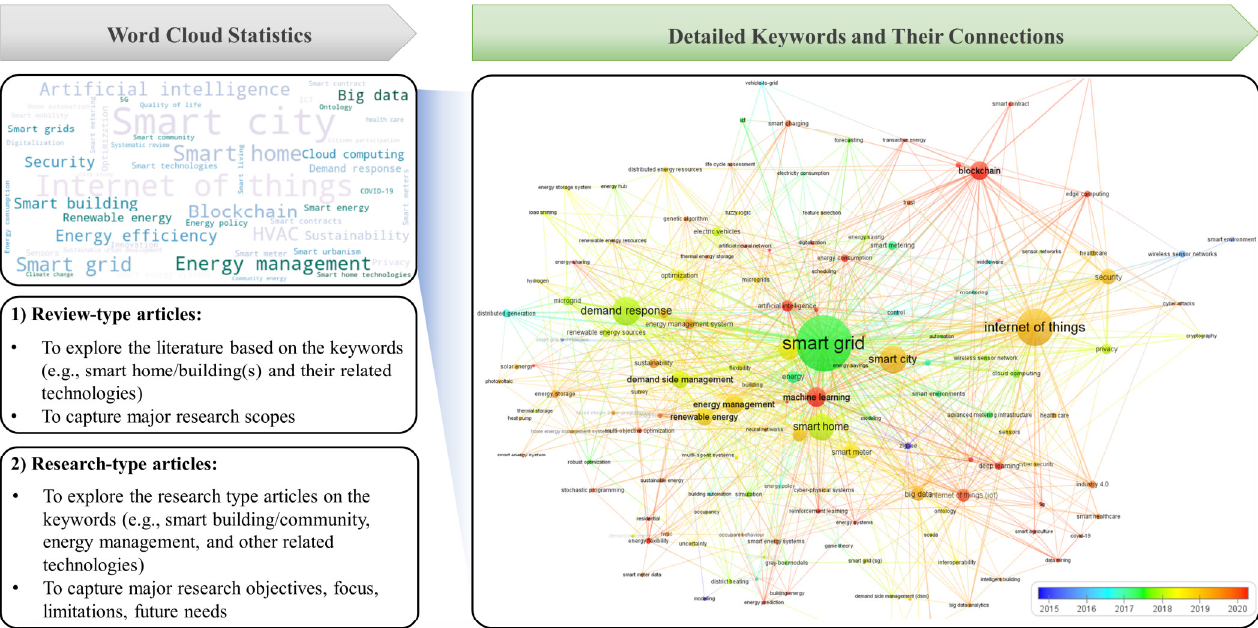
Figure 1. Workflow of the systematic review process for the study.